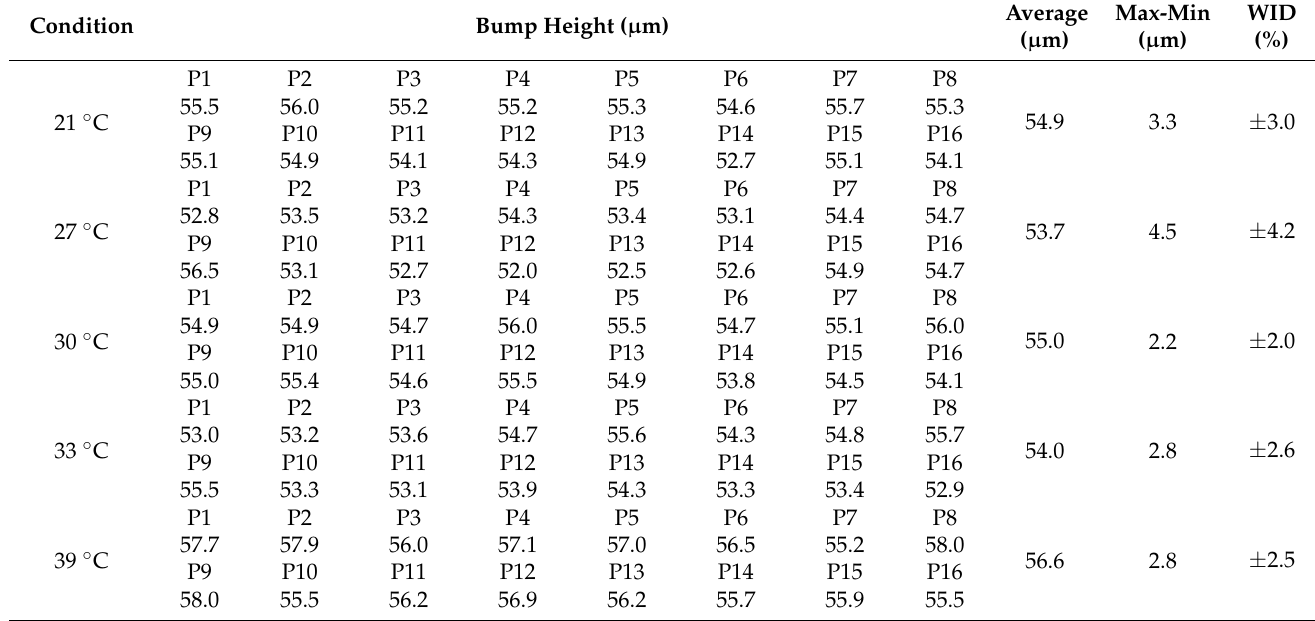
Table 5. Condition and measurement of Sn microbumps by current density.